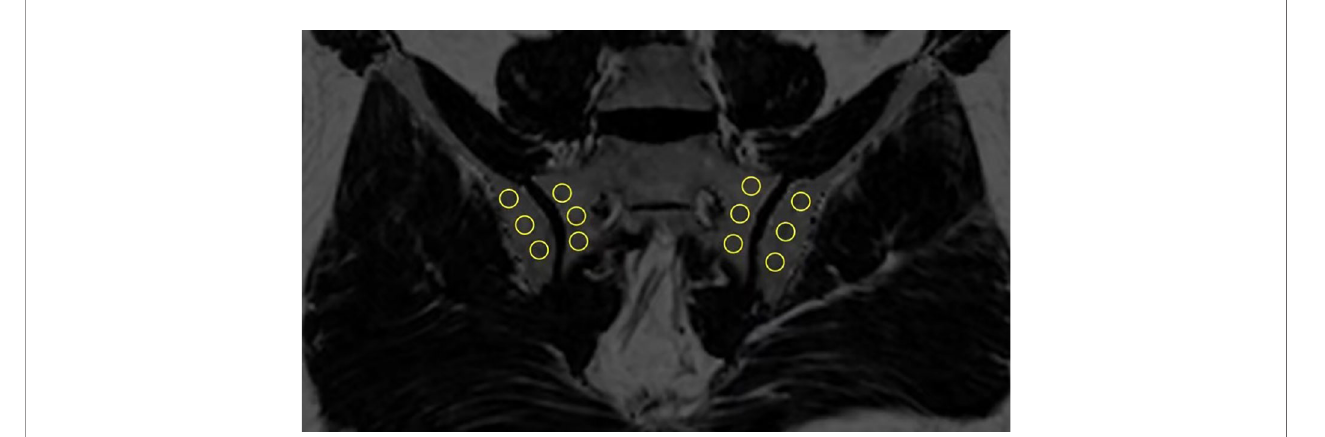
FIGURE 1 | Placement of ROIs in the subchondral area in the SIJs (ROI, regions of interest; SIJs, sacroiliac